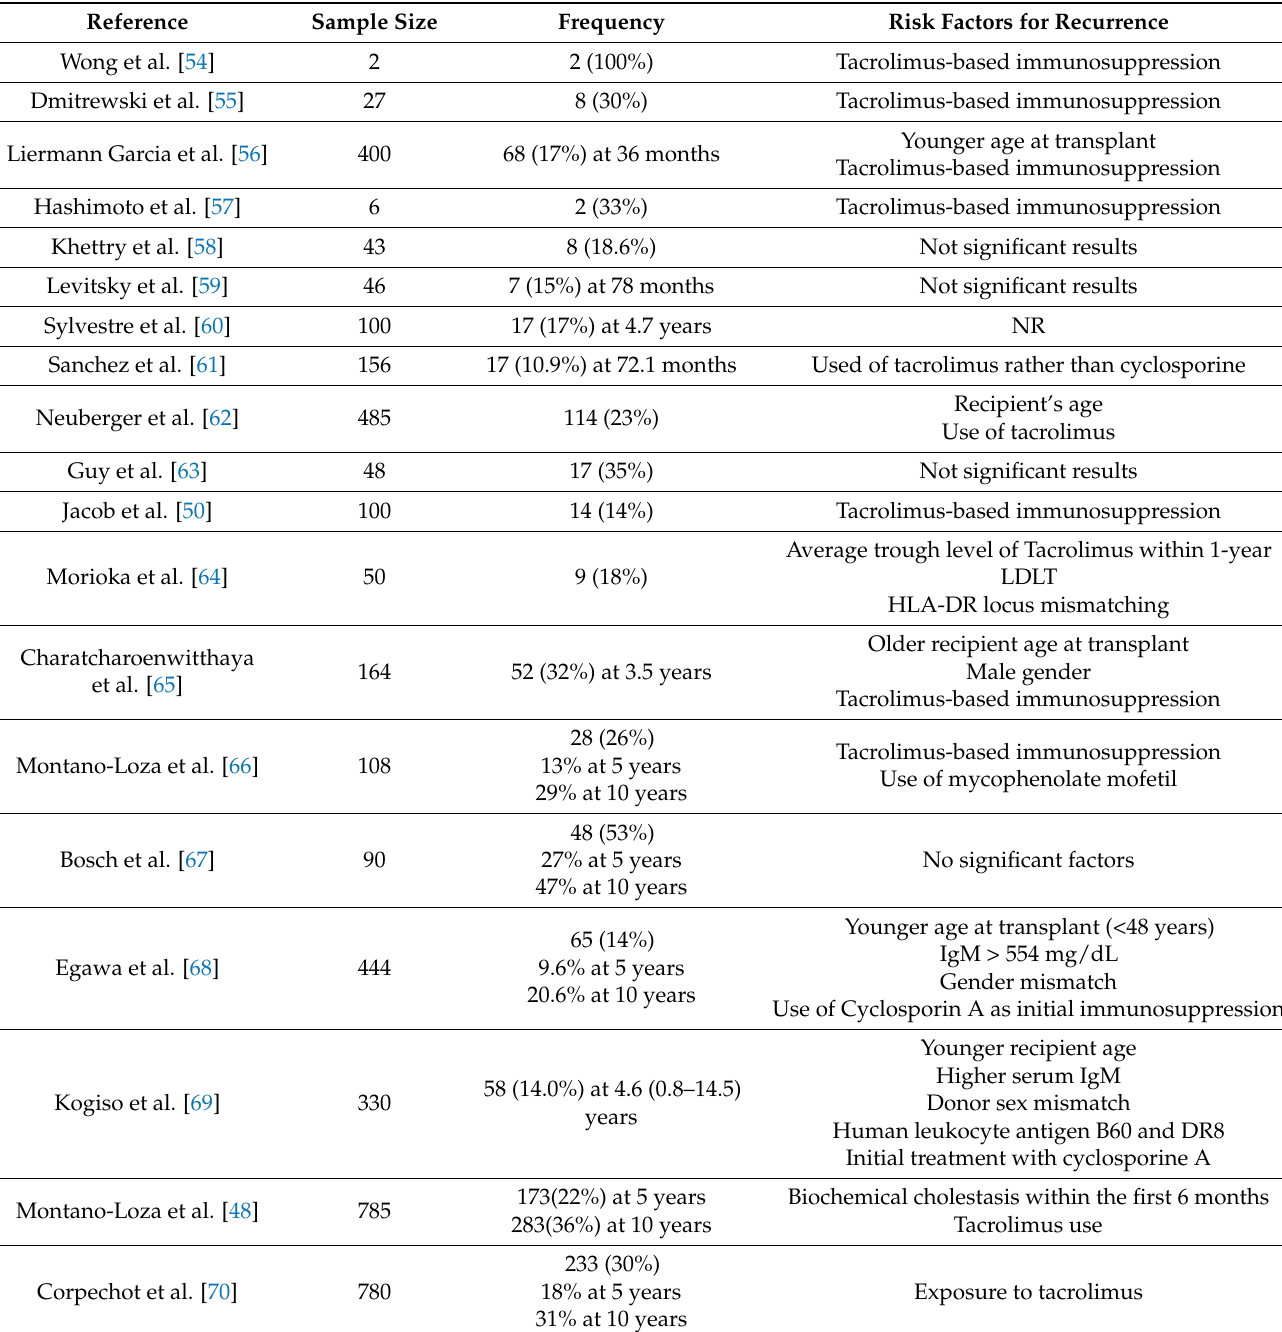
Table 2. Frequency and risk factors for recurrence of Primary Biliary Cholangitis after liver